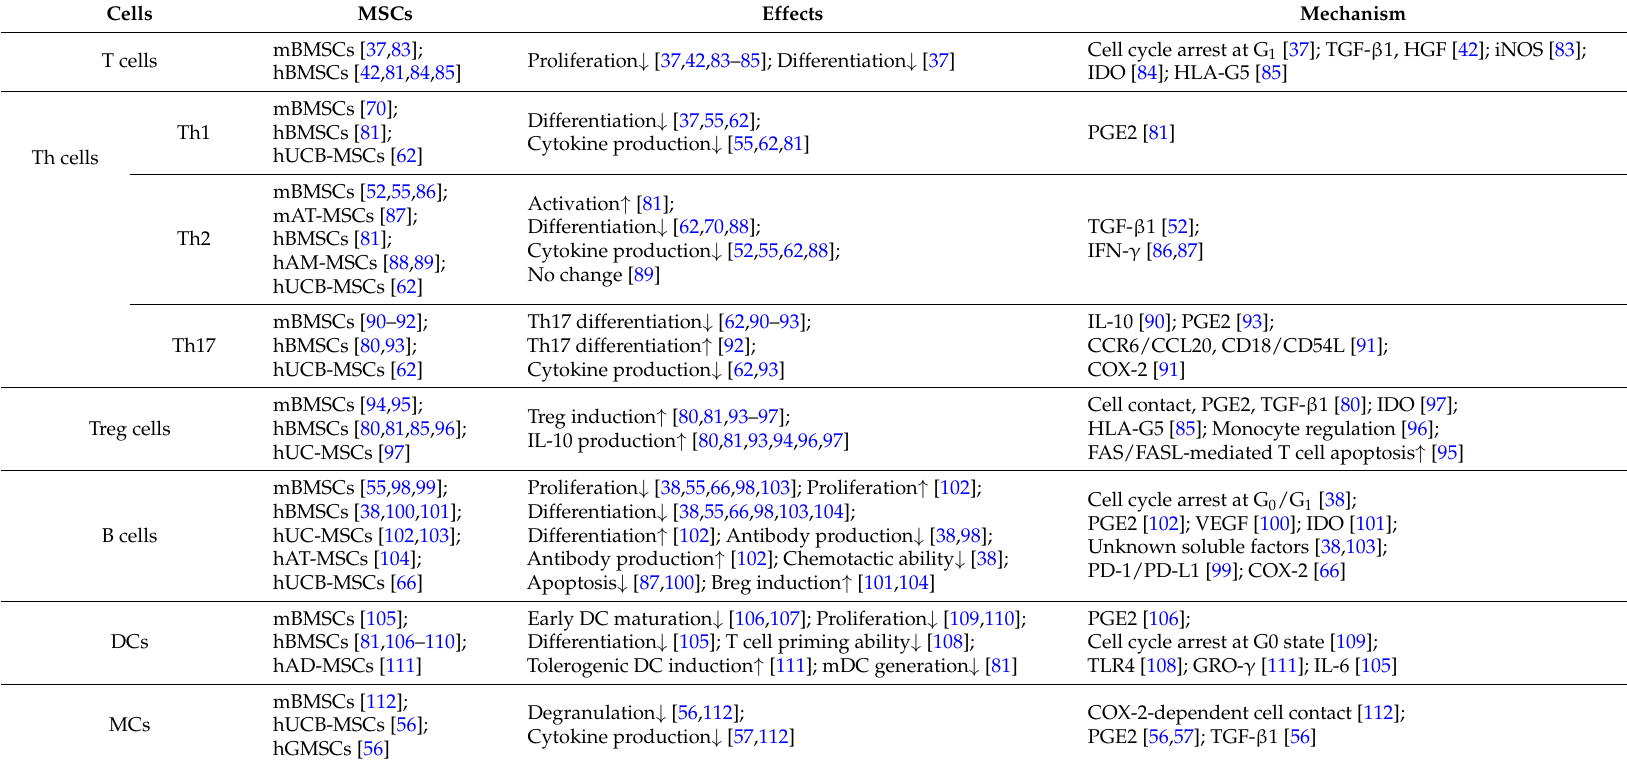
Table 3. Mechanisms of MSC-mediated regulation on inflammation-exacerbating immune